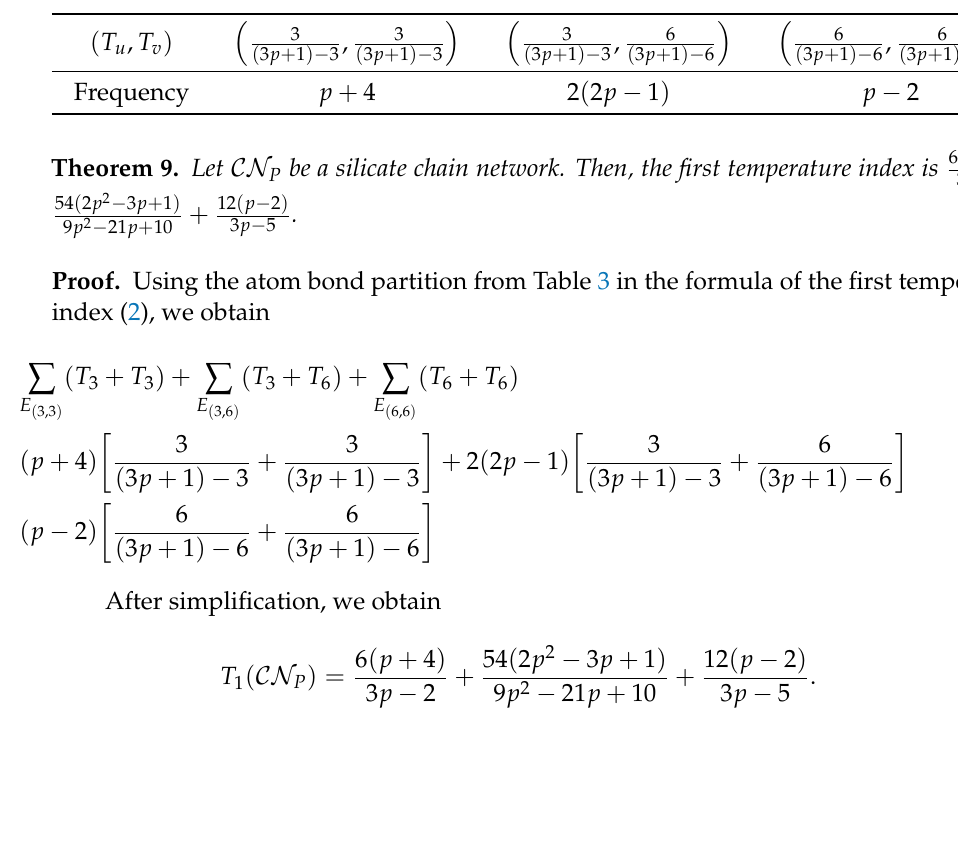
Table 3. Atom bond partition of CN P based on the valency of each atom of SiO